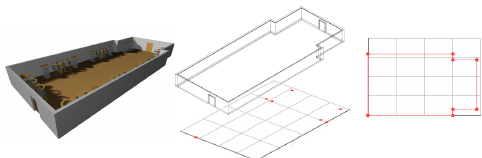
Figure 2: Extracting the representation of a room from an IFC model.